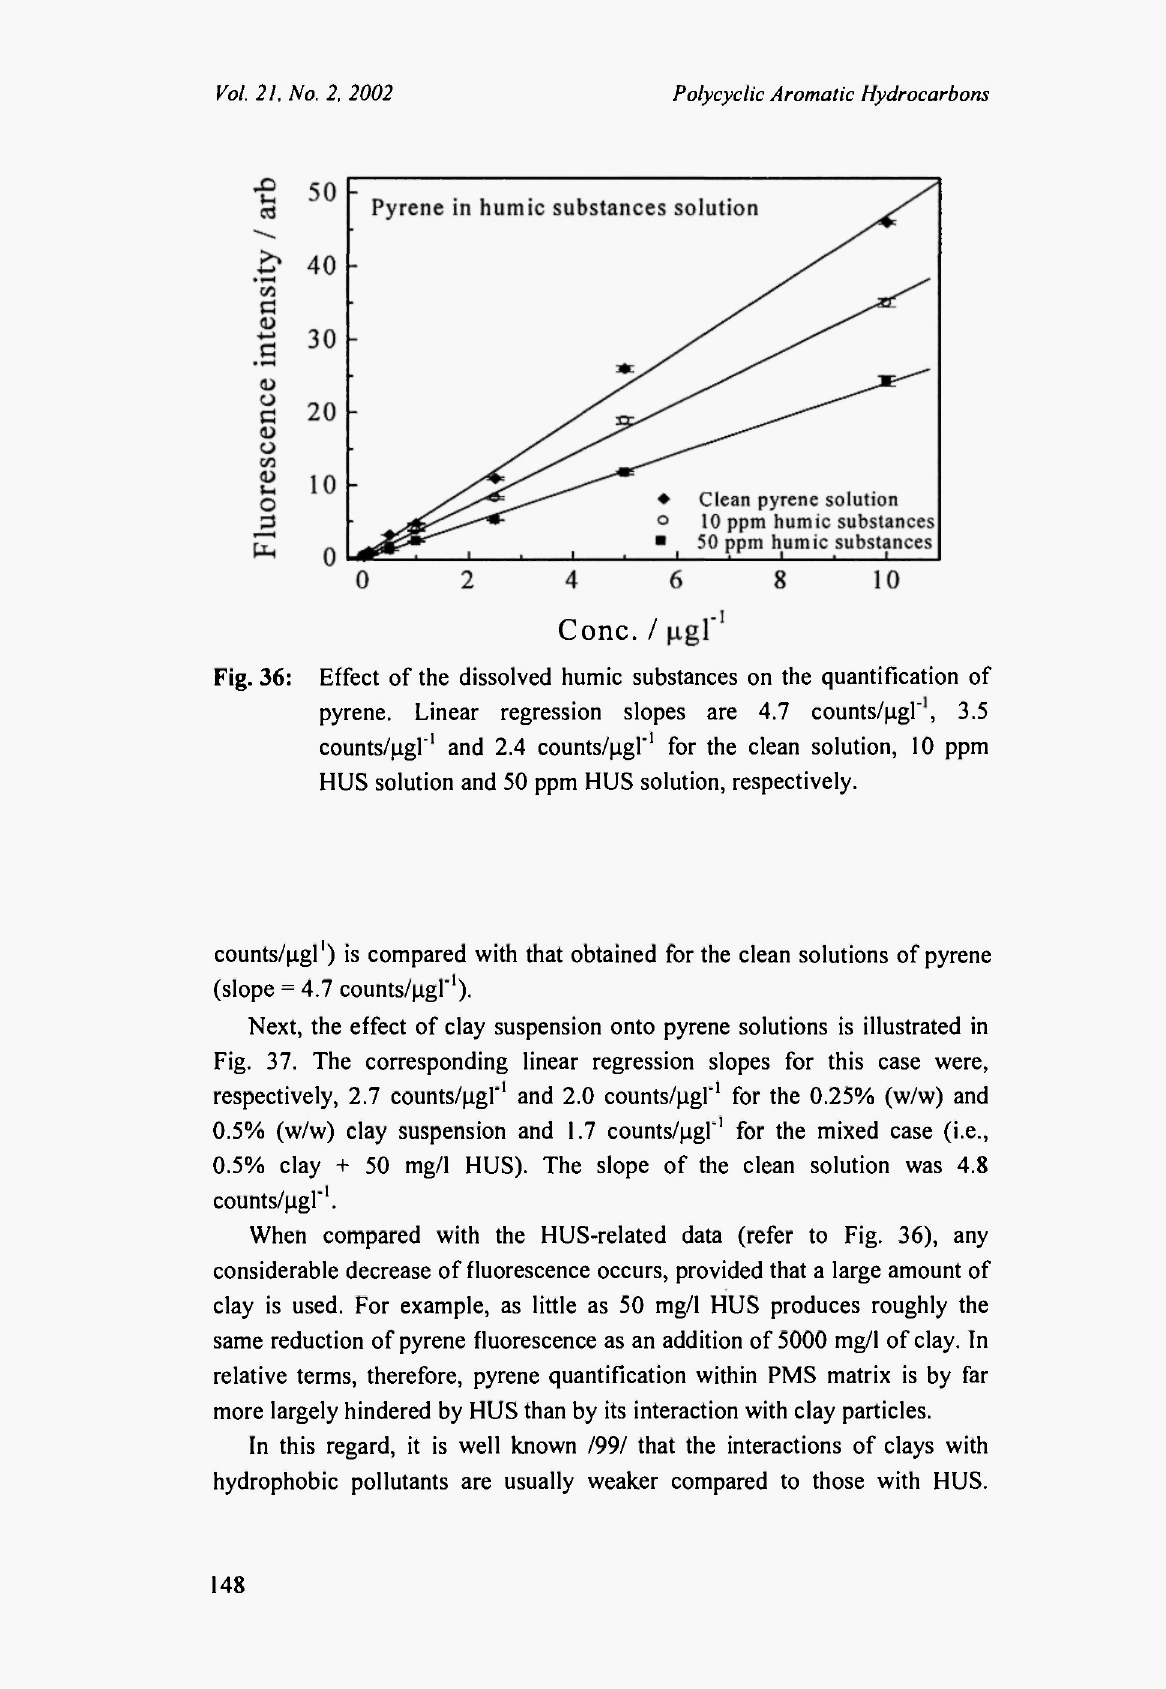
Cone. / Fig. 36: Effect of the dissolved humic substances on the quantification of pyrene. Linear regression slopes are 4.7 counts^gl', 3.5 counts/^gl" 1 and 2.4 counts^gl' 1 for the clean solution, 10 ppm HUS solution and 50 ppm HUS solution,